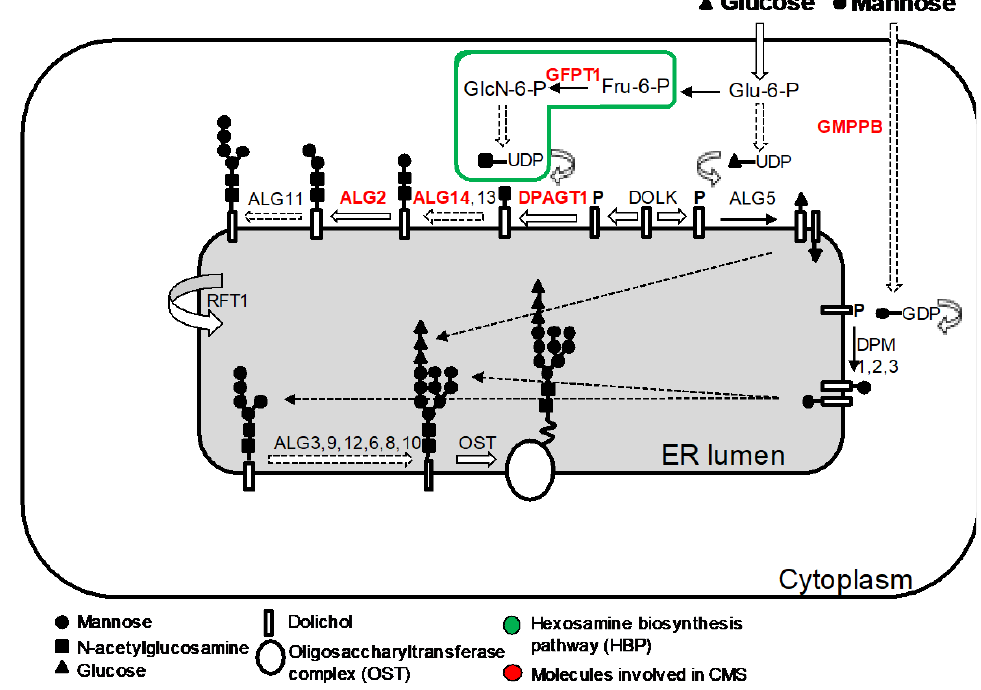
Figure 7. Simplified representation of the N -glycosylation pathway of proteins and the molecules involved in CMS. The N -linked glycosylation of proteins takes place in the ER. It starts with the assembly of the core glycan ( N -acetylglucosamine, glucose and mannose) on the lipid dolichol. A series of cytosolic glycosyltransferases proceed to dolichol glycosylation on the cytoplasmic face of the ER: GFPT1 synthesizes UDP-GlcNAc (Uridine diphosphate N -acetylglucosamine); DPAGT1 and